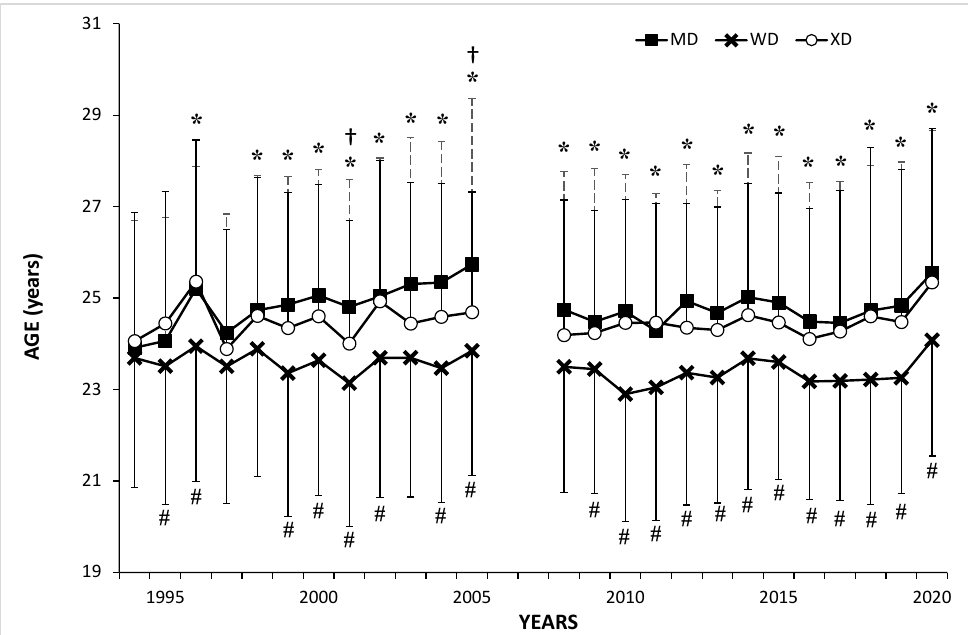
Figure 1. Evolution of mean age in men’s doubles (MD), women’s doubles (WD) and mixed doubles (XD) badminton players present in the WR top-100 from 1994 to 2020. * Differences between MD and WD in pairwise comparisons ( p < 0.05).; † Differences between MD and XD in pairwise comparisons ( p < 0.05). # Differences between WD and XD in pairwise comparisons ( p < 0.05).